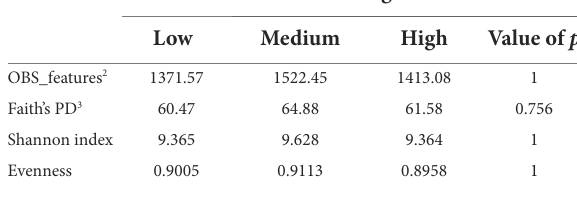
different ( p ≤ 0.05) according to Bonferroni’s multiple